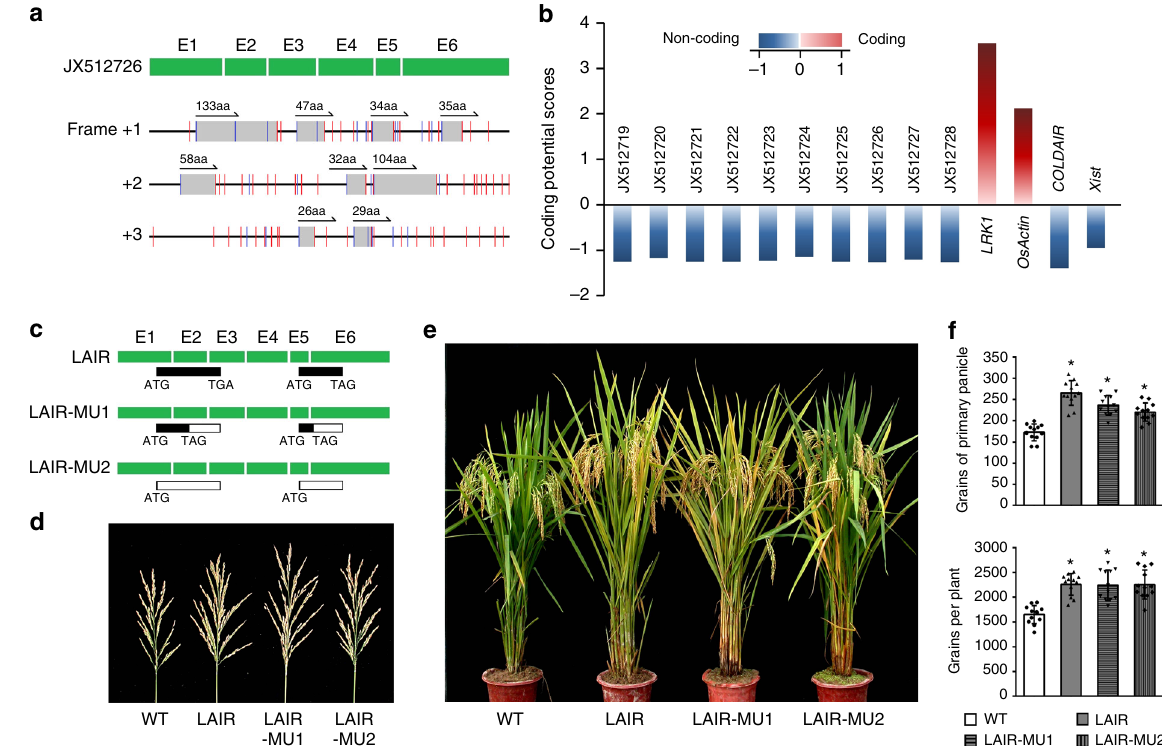
Fig. 2 LAIR coding potential analysis. a Analysis of the LAIR open reading frame (JX512726). All frames (gray boxes) were identi fi ed in the three forward frames. The two longest open reading frames encoded 133 and 104 amino acids (aa). Blue and red lines represent the start and stop codons, respectively. b Analysis of the coding potential of the alternatively spliced LAIR isoforms (Supplementary Fig. 2). Coding potential scores were generated using the CPC program. Transcripts with scores beyond − 1 and 1 are marked as non-coding or coding in this CPC classi fi cation 28 . LRK1 and OsActin are provided as coding examples, while COLDAIR and Xist represent non-coding examples. c LAIR -mutant vectors were constructed based on the two longest open reading frames, which encoded 133 aa and 104 aa. A single nucleotide mutation introduced a premature stop codon in LAIR-MU1. A single nucleotide was deleted after the start codon (ATG) in LAIR-MU2. d , e Phenotypes of WT, LAIR, and transgenic plants carrying the LAIR mutant vectors. Growth traits of T 3 transgenic lines were investigated, including mature plant phenotype ( e ) and primary panicle size ( d ). f Growth traits of LAIR-MU1 and LAIR-MU2 transgenic lines. Student ’ s t -test: * P < 0.05. Data are presented as the mean ± standard deviation ( n =